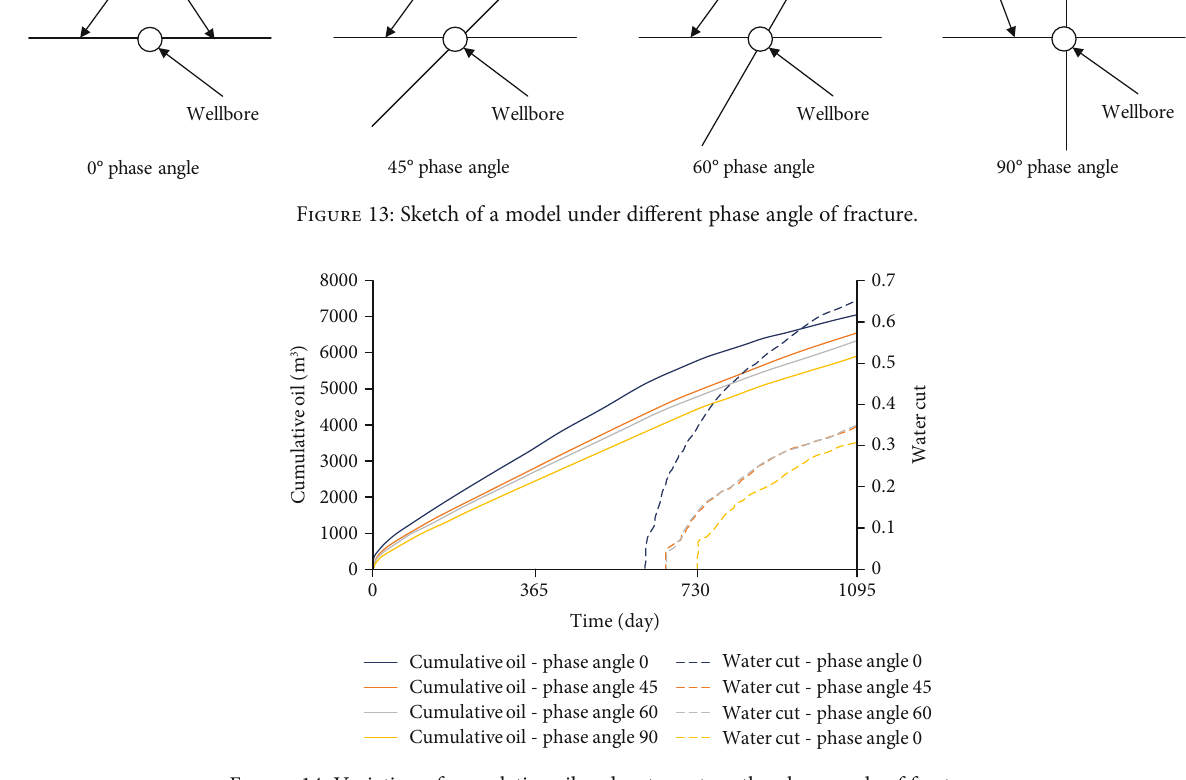
Figure 14: Variation of cumulative oil and water cut on the phase angle of fracture.